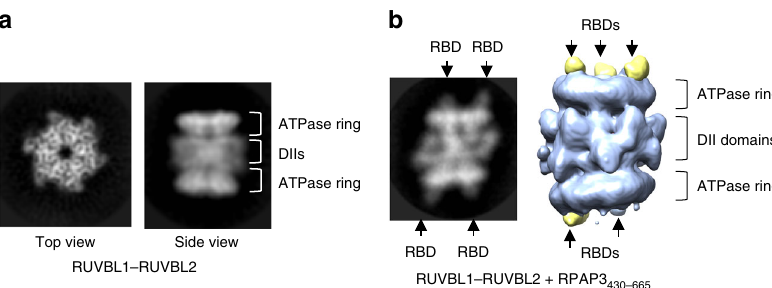
Fig. 2 Cryo-EM imaging of RUVBL1 – RUVBL2 and the RBD domain. a 2D averages corresponding to top and side views obtained from cryo-EM images of the RUVBL1 – RUVBL2 preparation in an ADP-containing buffer. b After incubation with RPAP3 430 – 665 , RBDs decorate the ATPase side of both RUVBL rings without disrupting the dodecamer, and a representative 2D average of the complex between RUVBL1 – RUVBL2 and RBD is shown. At the right end of the panels, one view of the 3D structure of RUVBL1 – RUVBL2 – RBD complex with RBD domains in yellow. Note that one of the RBD domains in the bottom ring is less visible at the threshold used for rendering, probably re fl ecting variable occupancy. Also, the scale of the 3D structure has been enlarged with respect to the 2D average, for clarity